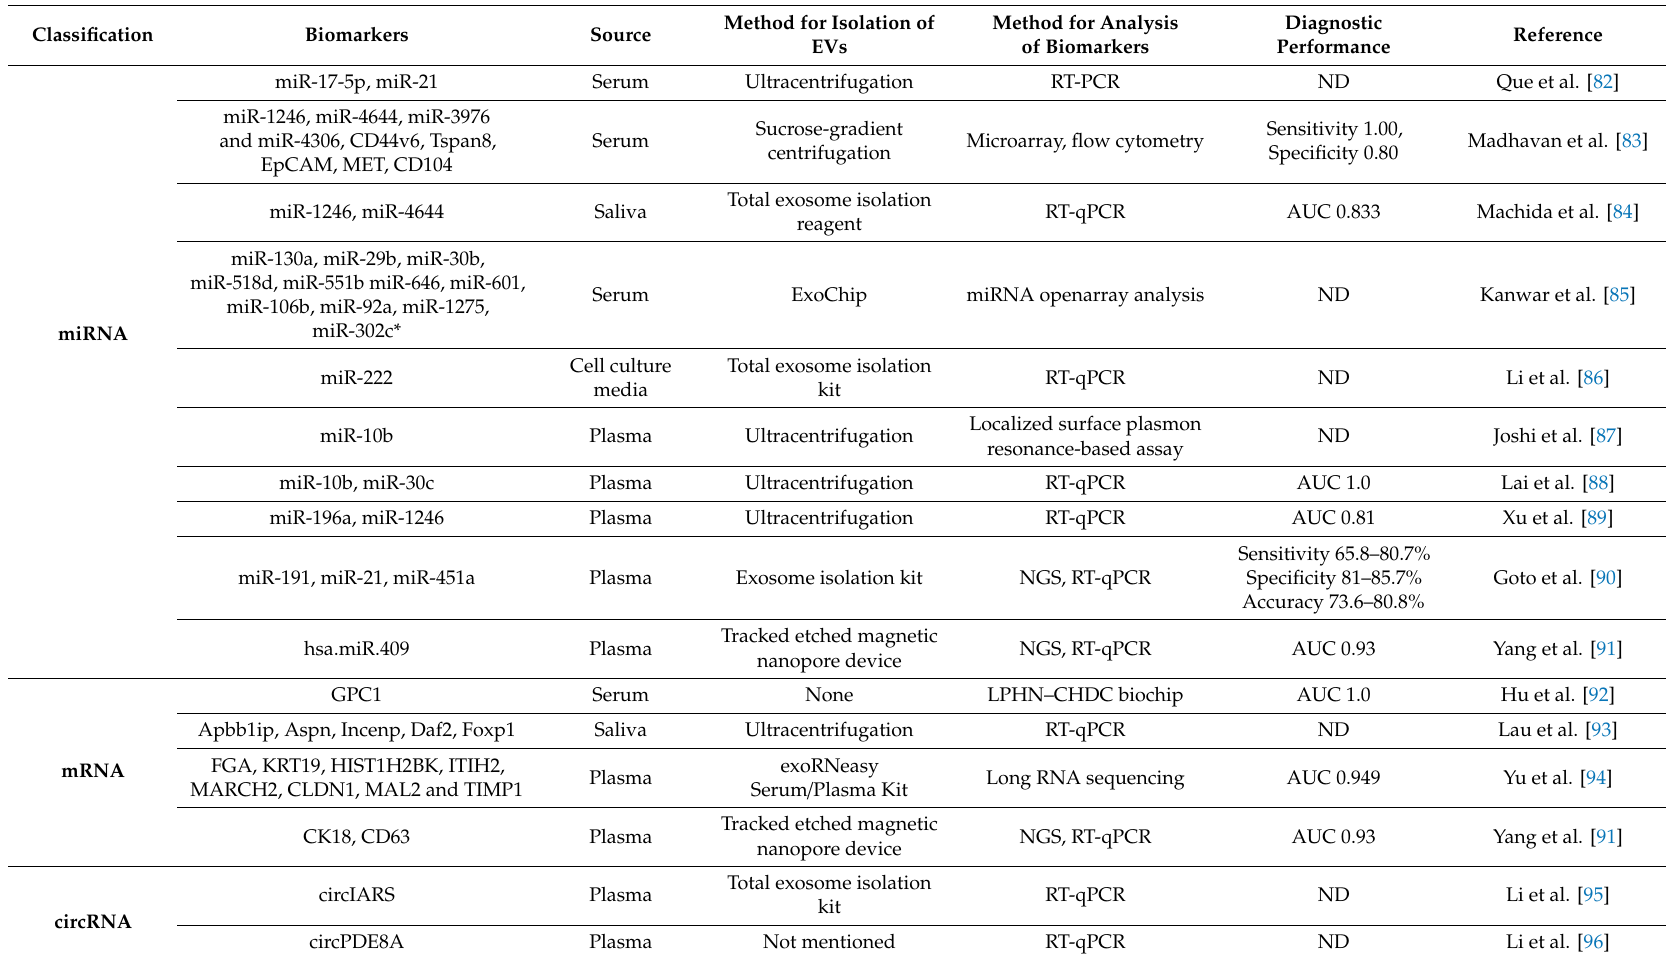
Table 3. Panels of EV RNA biomarkers for early detection and diagnosis of pancreatic